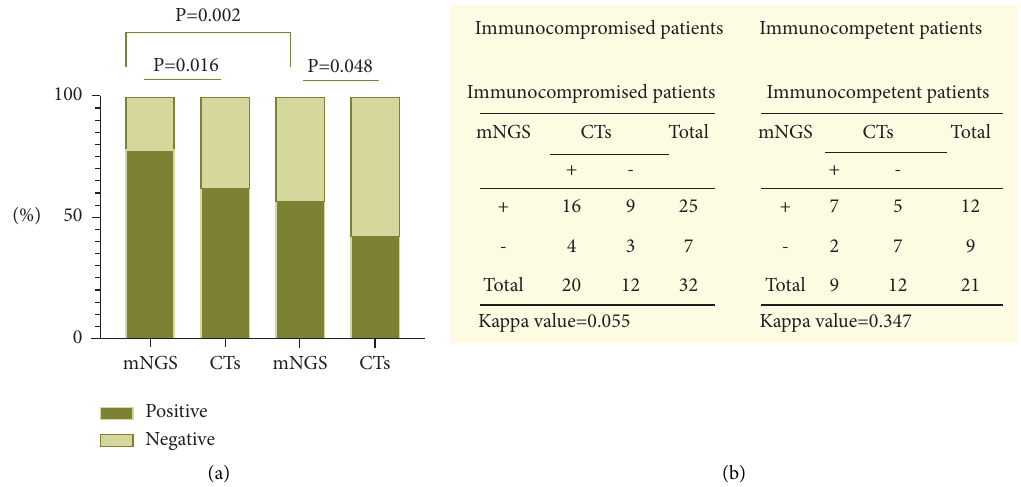
Figure 5: Te positivity rate comparison and concordance analysis between mNGS and CTs. (a) Te comparisons of the positive rates for mNGS and CTs in immunocompromised patients and immunocompetent patients ( P < 0 . 05). (b) Concordance tests and kappa values were shown between mNGS and CTs for immunocompetent patients and immunocompromised